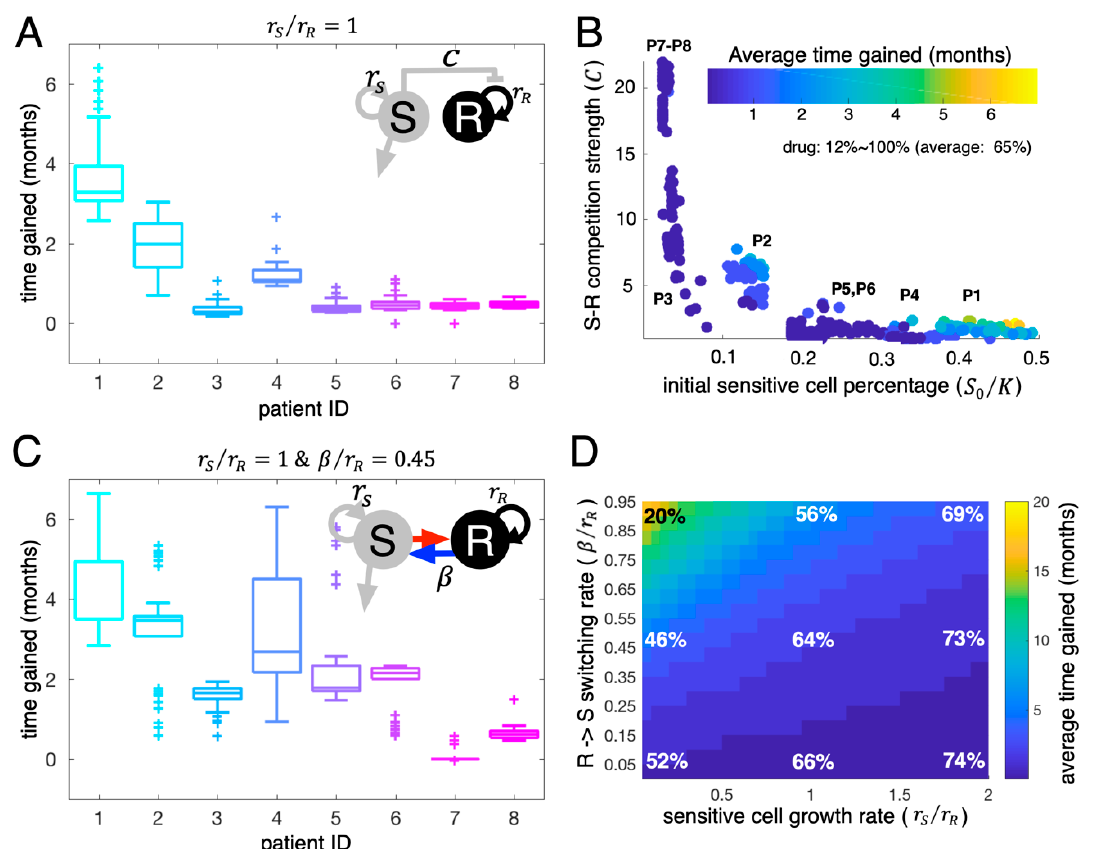
Figure 4. Adaptive therapy simulations. ( A ) The LV model predicted time gained in months with adaptive therapy compared to continuous therapy (time to progression under adaptive therapy − time to progression under continuous therapy) for all eight patients. All model parameters except the growth rate of sensitive cells are estimated from the LV model fits to individual patient LDH data. The intrinsic growth rate of sensitive cells was set to be the same as the estimated intrinsic 𝑟 (cid:3020) growth rate of resistant cells ( 𝑟 (cid:3019) (cid:3415) = 1 ). ( B ) Time gained of all 400 virtual patients (50 virtual patients for each actual patient and eight actual patients) as a function of initial sensitive cell proportion ( 𝑆 (cid:2868) /𝐾 ) and S-R competition coefficient ( 𝐶 ). Dots: Average virtual patient assuming 𝑟 (cid:3020) = 5–200% of the estimated 𝑟 (cid:3019) per each estimated parameter set obtained from the real patients. ( C ) The SW model predicted time gained in months with adaptive therapy for all eight patients. All model parameters except for the intrinsic growth rate of sensitive cells ( 𝑟 (cid:3020) ) and R S transition rate ( 𝛽 ) were estimated from SW model fits to LDH data. The intrinsic growth rate of sensitive cells was set to be the same as the estimated intrinsic 𝑟 (cid:3020) growth rate of resistant cells ( 𝑟 (cid:3019) (cid:3415) = 1 ) and the 𝛽 was set to 45% of the estimated intrinsic growth rate of resistant cells ( 𝛽 = 0.45𝑟 (cid:3019) ). ( D ) Average time gained for all 400 virtual patients varied with the intrinsic growth rate of the sensitive cells (𝑟 (cid:3020) = 0.05𝑟 (cid:3019) ~2𝑟 (cid:3019) ) and the R S transition rate ( 𝛽 = 0.05𝑟 (cid:3019) ~0.95𝑟 (cid:3019) ). Color: time gained in months. Percent represents the average dose rate relative to continuous therapy.